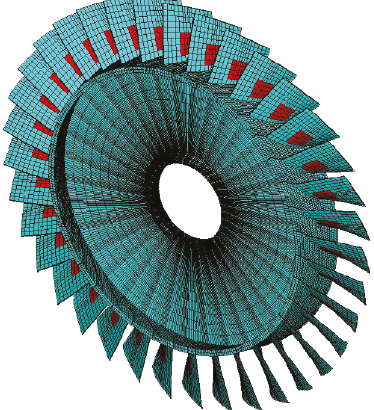
Figure 1: Illustration of the blisk with piezo-patches (the red region represents the